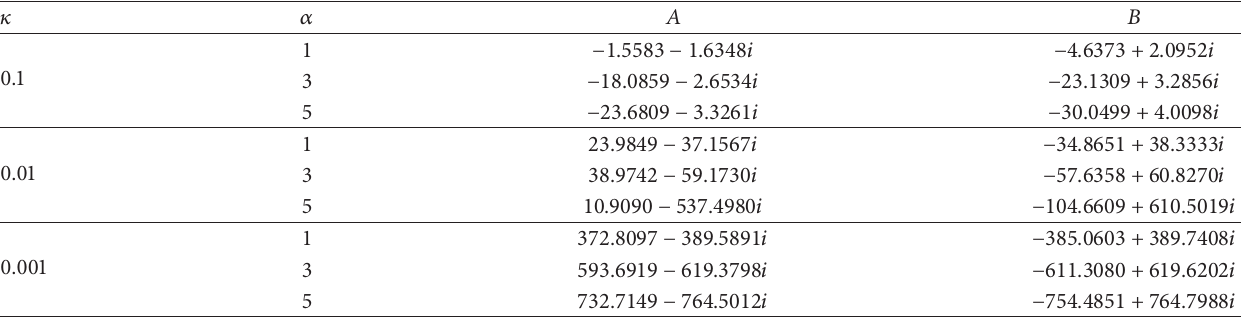
Table 1: 𝐴 and 𝐵 values for different sets of model